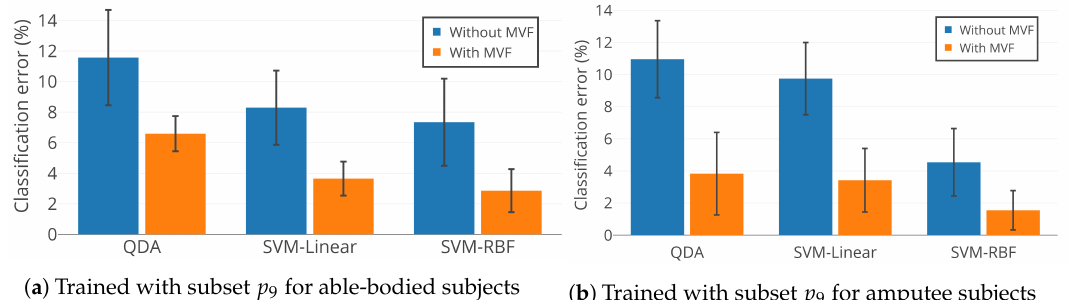
Figure 10. Classification performance of QDA, SVM-Linear, and SVM-RBF with feature subset p 9 for able-bodied subjects (AB01, AB02, and AB03) and amputee subjects (AM01, AM02, and